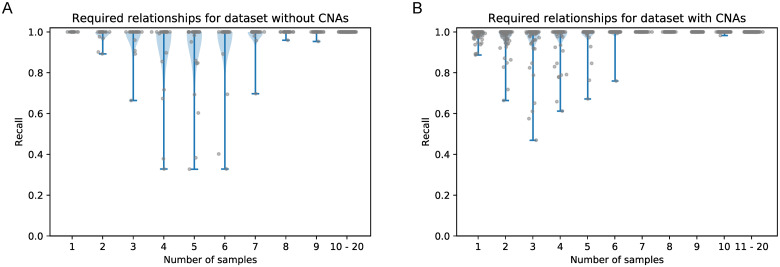
Recall of defined ancestral relationships for dataset (A) without and (B) with CNAs.We computed recall based on the non-trivial ancestral relationships. Columns in (A) usually have 30 data points, columns in (B) 90. The last column in each subfigure shows all results for (A) 10 and (B) 11 and more samples since each subMAR achieved a recall of 100%. For the 64 subMARs for which the DFS could not enumerate all valid (and equivalent) completing clone trees, we did not compute the recall because we do not know the ground truth. Hence, column 1 of (A) contains only 13, column 2 20, column 3 21 and column 4 27 values, and column 1 of (B) contains only 65 values.